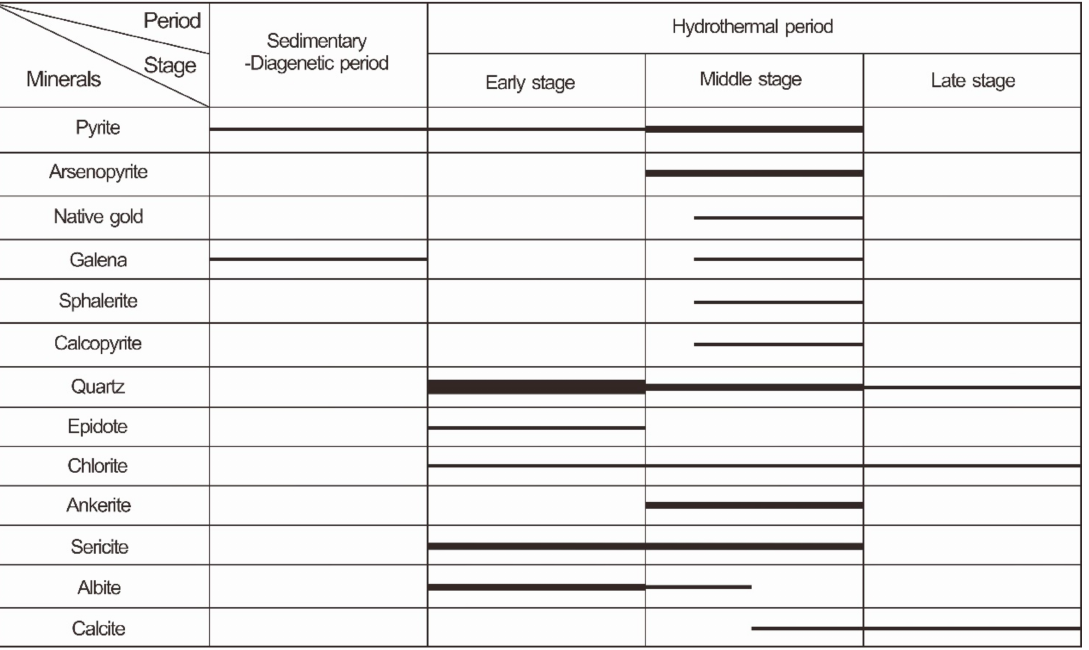
Figure 6. The mineral paragenesis sequence of the Dunbasitao gold deposit (according to Liu et al. [35]). The thickness of the line represents the amount of that mineral.